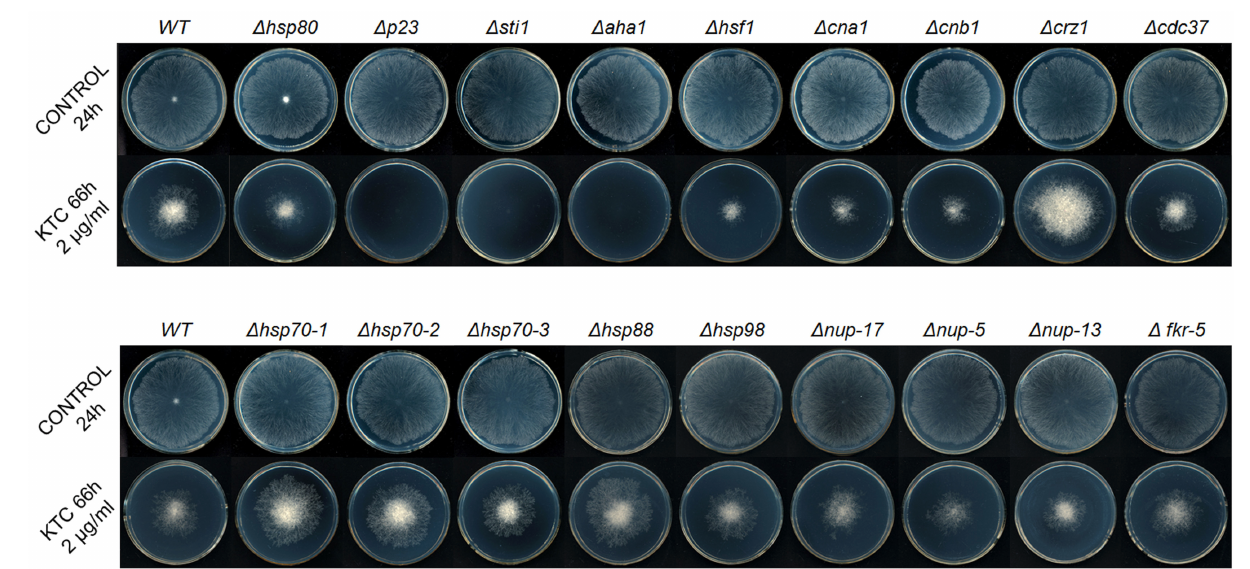
FIGURE 1 | Susceptibility tests of wild-type N. crassa and the knockout mutants of Hsp90 orchestrates member genes [ hsp80 , hsp70-1 , hsp70-2 , hsp70-3 , p23 , aha1 , sti1 , cdc37 , nup-17 ( PPIase ), nup-5 ( PPIase B ), nup-13 ( PPIase H ), and fkr-5 ( PPIase FKBP-type )], calcineurin encoding genes ( cna1 and cnb1 ), Hsp90/calcineurin-dependent stress responses genes ( crz1 and hsf1 ) and other heat shock protein family genes ( hsp88 and hsp98 ) to antifungal drug ketoconazole (KTC). Two microliters of conidial suspension (2 × 10 6 conidia/ml) were inoculated in the center of plates ( 8 90mm) with or without antifungal drug, then incubated at 28 ◦ C for the indicated times. Each test was duplicated and the experiment was independently repeated at least three times.